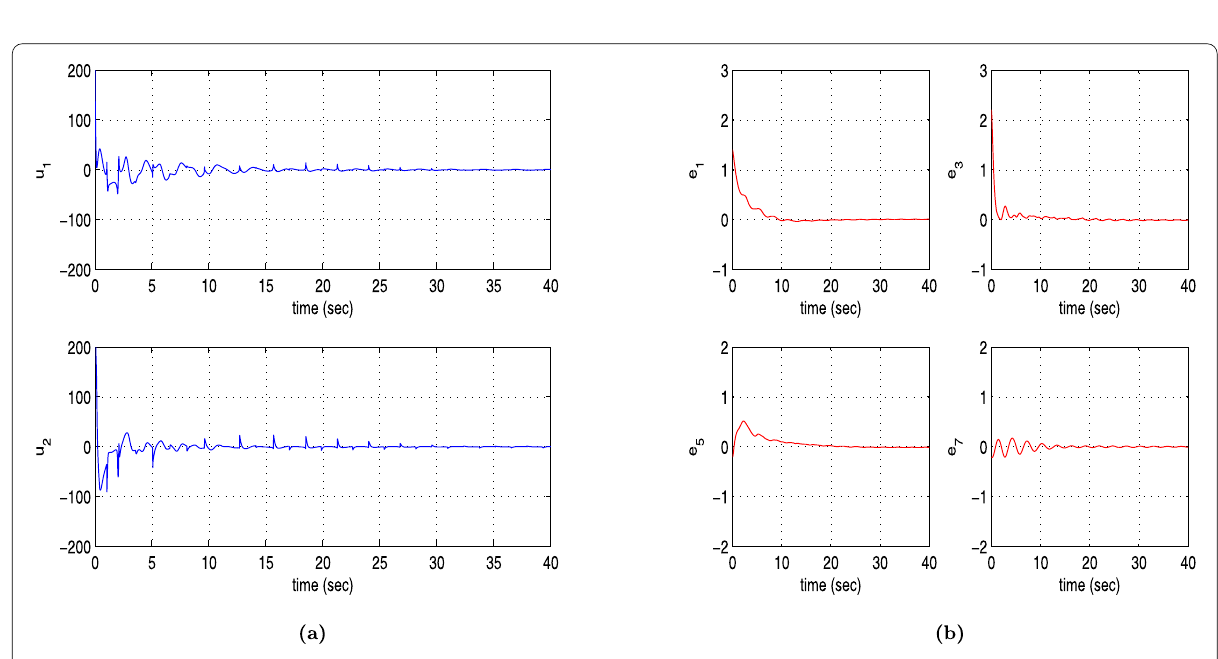
these approaches the linearization was performed around points of the desirable trajectory whereas in the present ar- ticle’s control method the linearization points are related